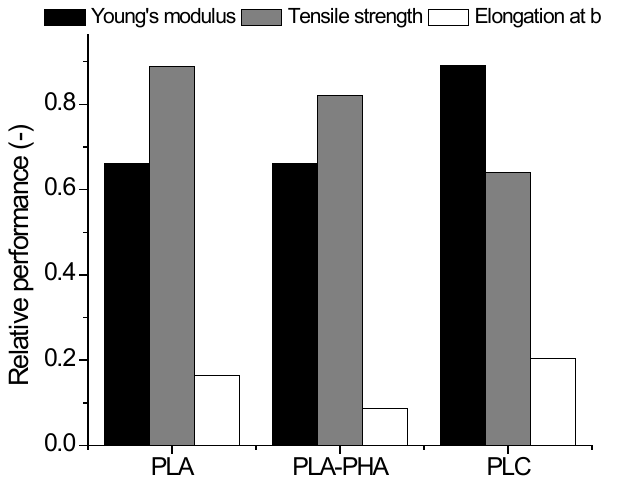
Figure 19. Comparison between the tensile performance of PLA, PLA-PHA, and PLC printed using horizontal orientation (HA) with a printing angle of 0°.